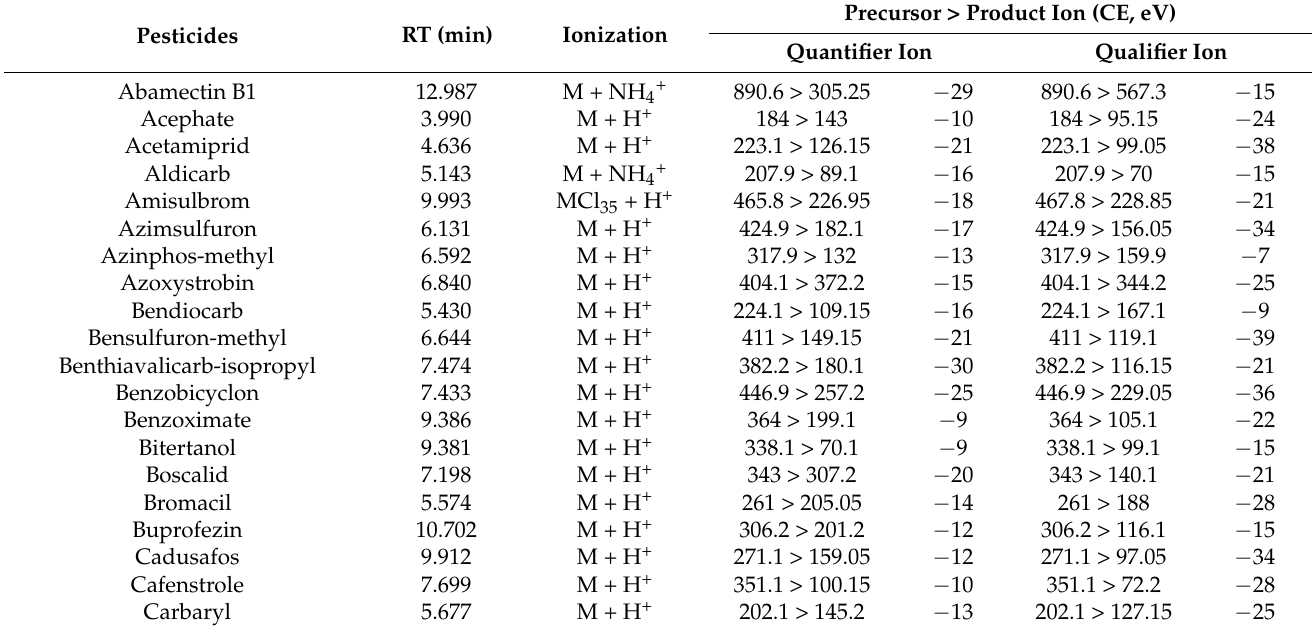
Table 2. MRM conditions for the first 40 pesticides in the LC–MS/MS analysis. MRM conditions for the other 179 pesticides are listed in Table